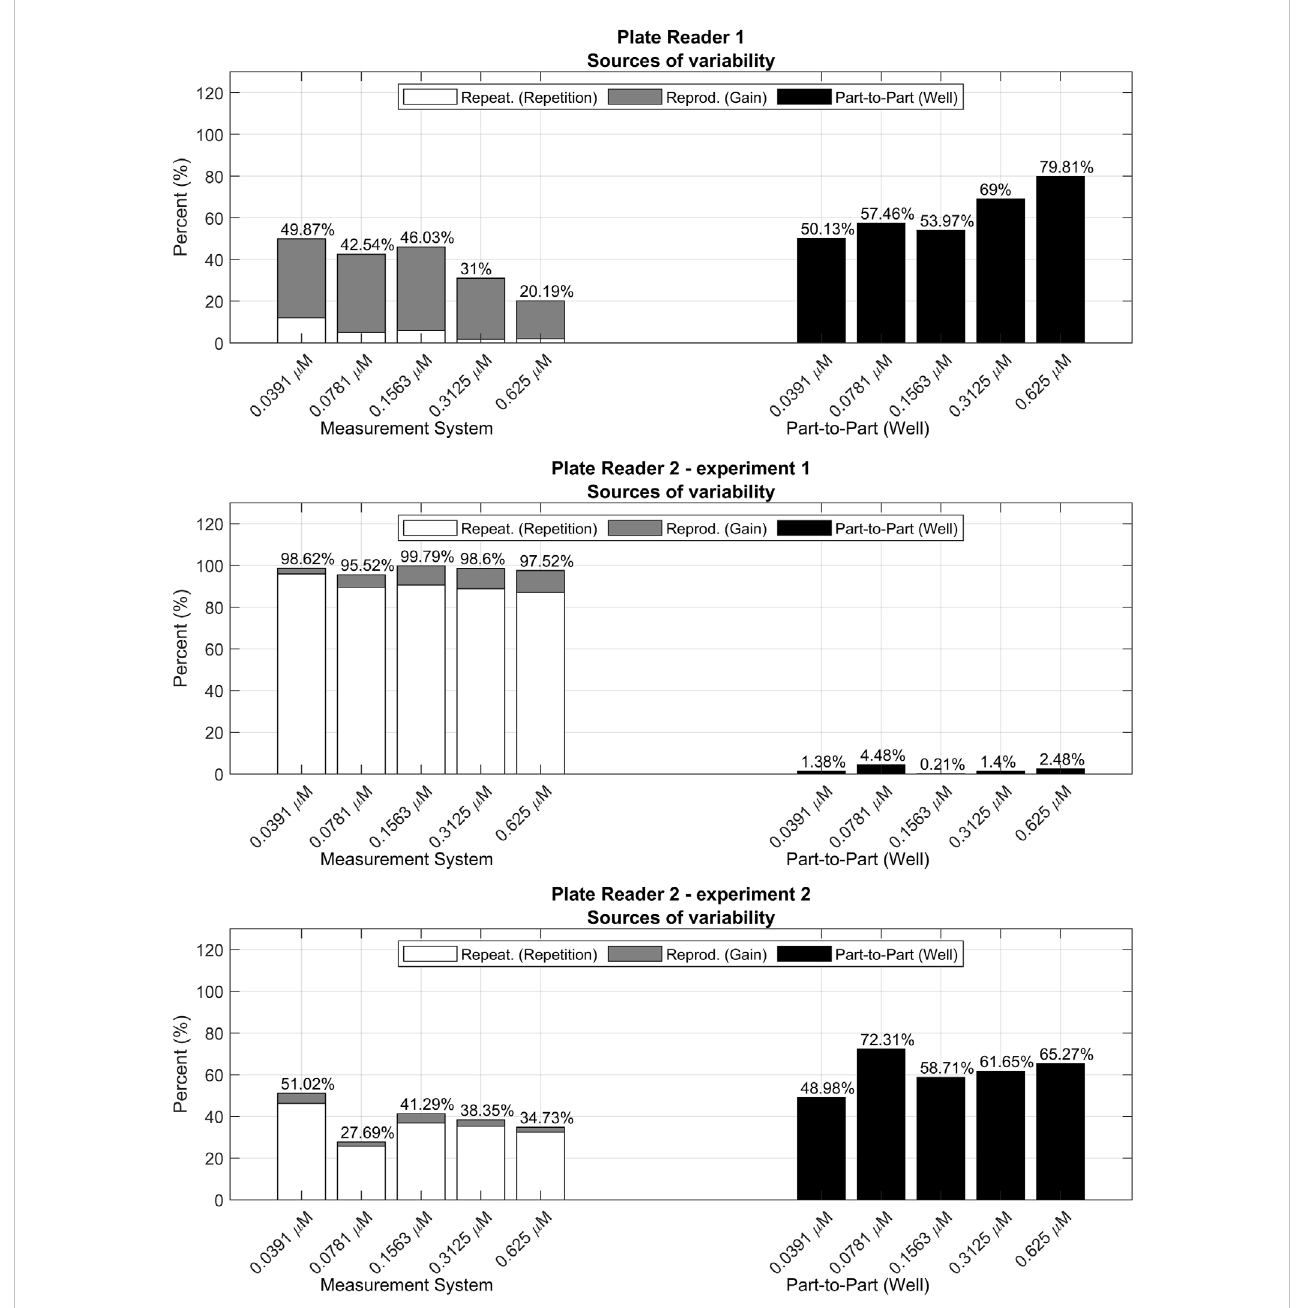
R&R analyses for the validation data sets measured with different plate readers and experimental